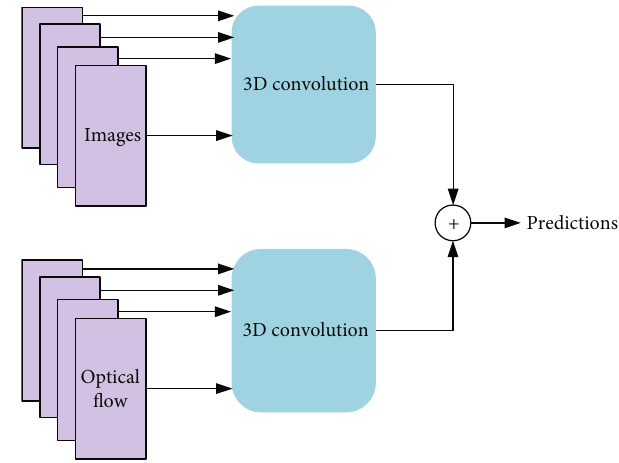
Figure 4: Dual-stream I3D model based on 3D